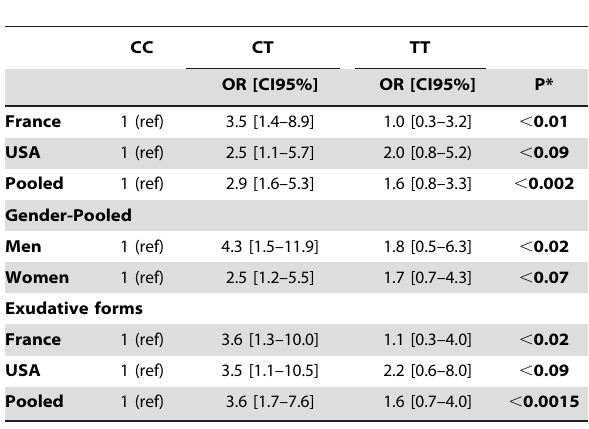
Adjustment for non genetic confounders: age, sex, and cigarette smoking. For table 4, OR are estimated by genotype (CT vs CC and TT vs CT) but the p values are global p values (with 2 degrees of freedom) for estimates a global effect of genotype (is at least one of the genotypes (CT or TT) significantly associated with increased rik of AMD). *Interaction with center; p , 0.29, interaction with sex (in pooled population), p , 0.48. Sample size: France: 61 cases and 72 controls – USA: 56 cases and 160 controls.